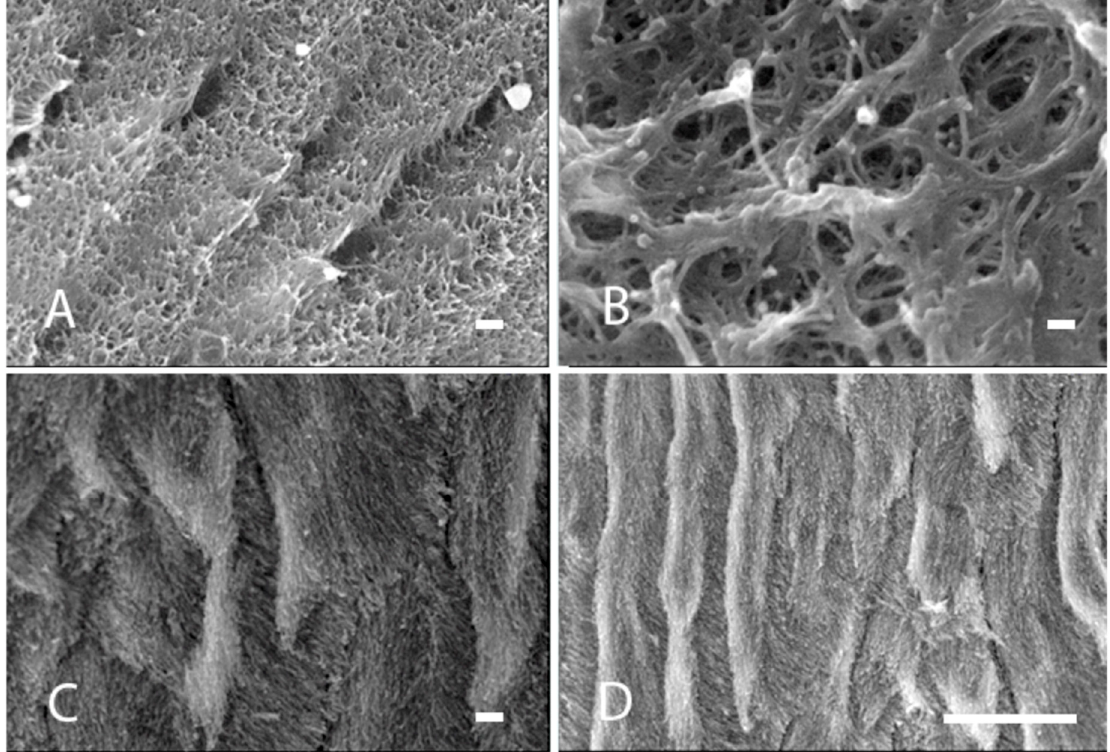
Figure 2. SEM analysis of enamel and dentin from OI patients. ( A , B ): Intertubular tissue and collagen fibers; ( C ): Enamel prisms; ( D ): Unpacked crystals of hydroxyapatite.